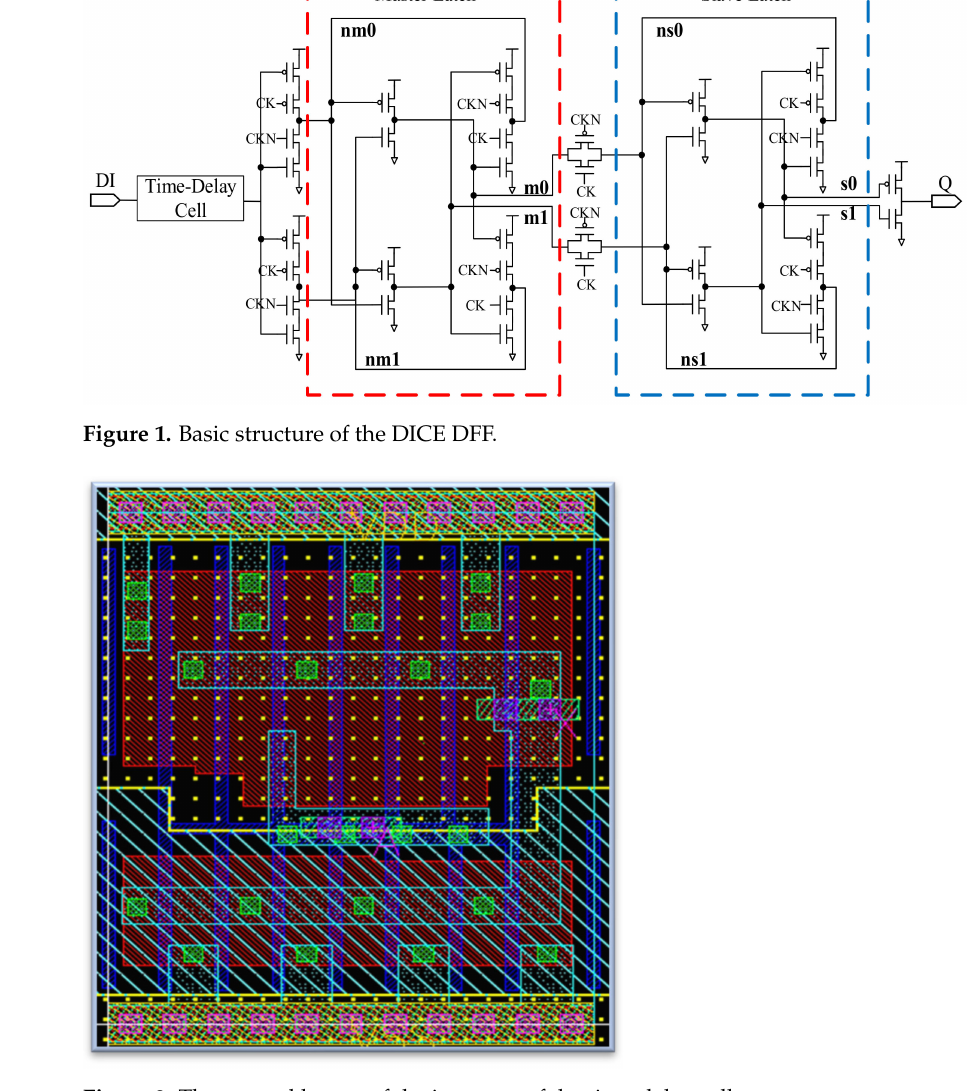
Figure 2. The general layout of the inverters of the time-delay cell.